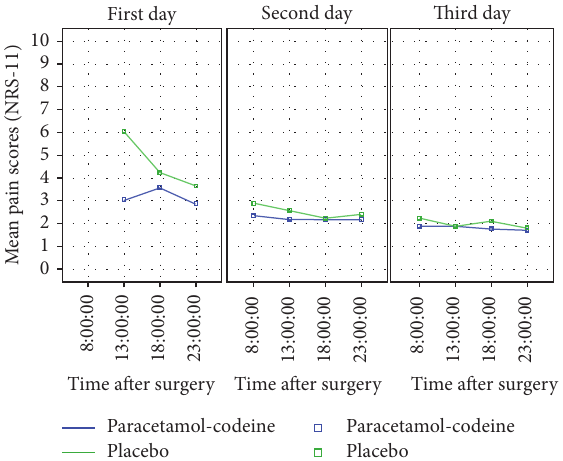
Figure 1: Pain intensity score (NRS-11) in the placebo and analgesic groups recorded at specific time intervals on the three days after surgery. Data are expressed as the mean and SD values. Significant difference in the NRS-11 score between the two groups was found only in the first day after surgery (𝑝 < 0.001) .